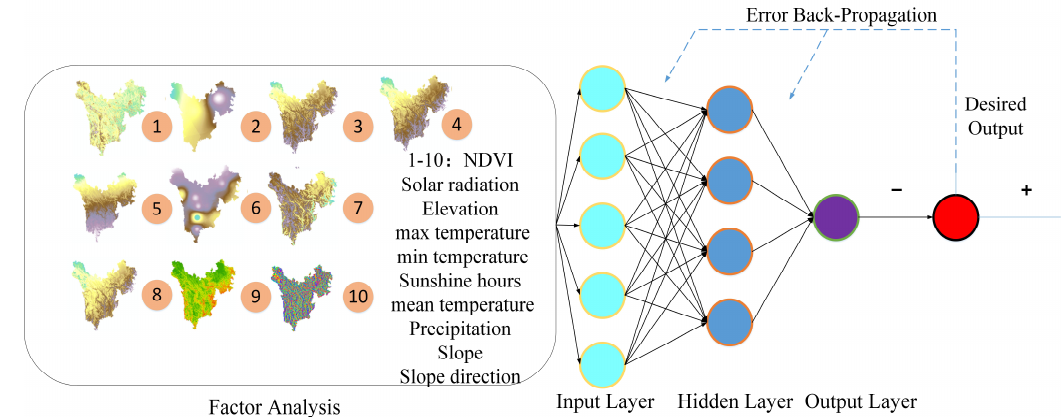
Figure 2. FA−BP neural network.2.2.2 NPP estimation and analysis